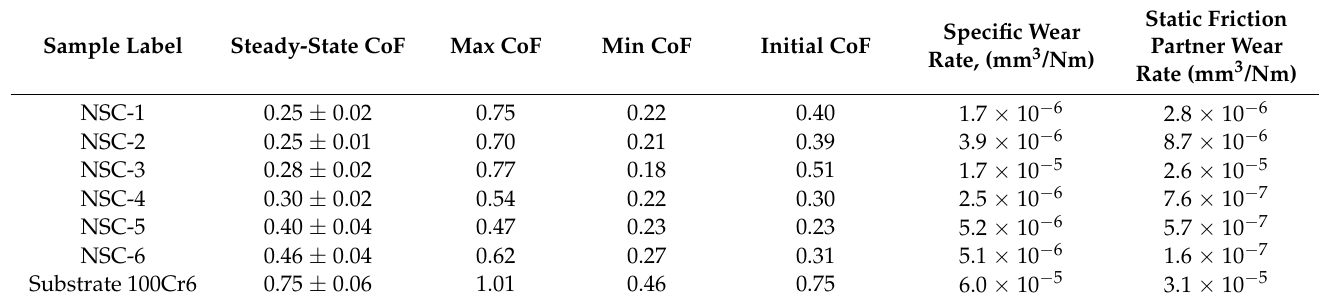
Table 3. Overview of the friction and wear